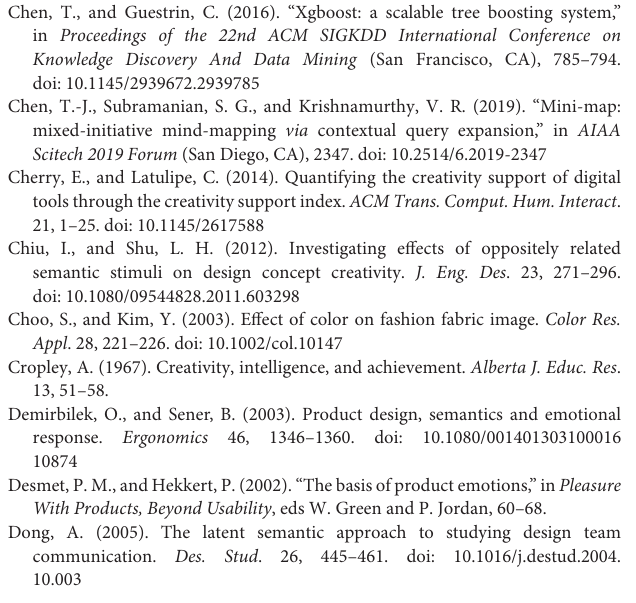
phrases rated by expert designers to assign the score for sorting new word1 - word2 combinations (Section 3.3, the function